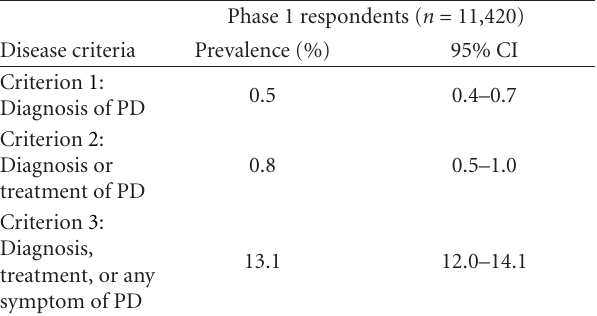
Table 3: Estimated prevalence of Peyronie’s disease in US males in